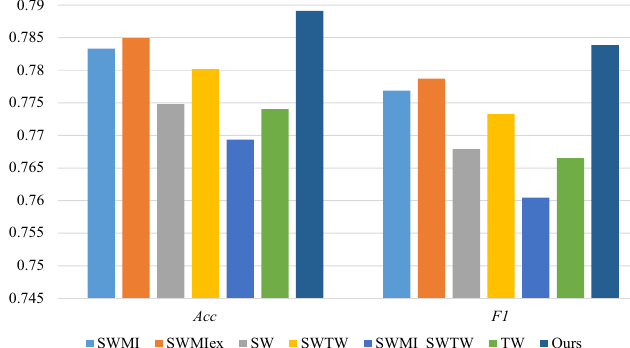
Figure 11. Performance using different online AR